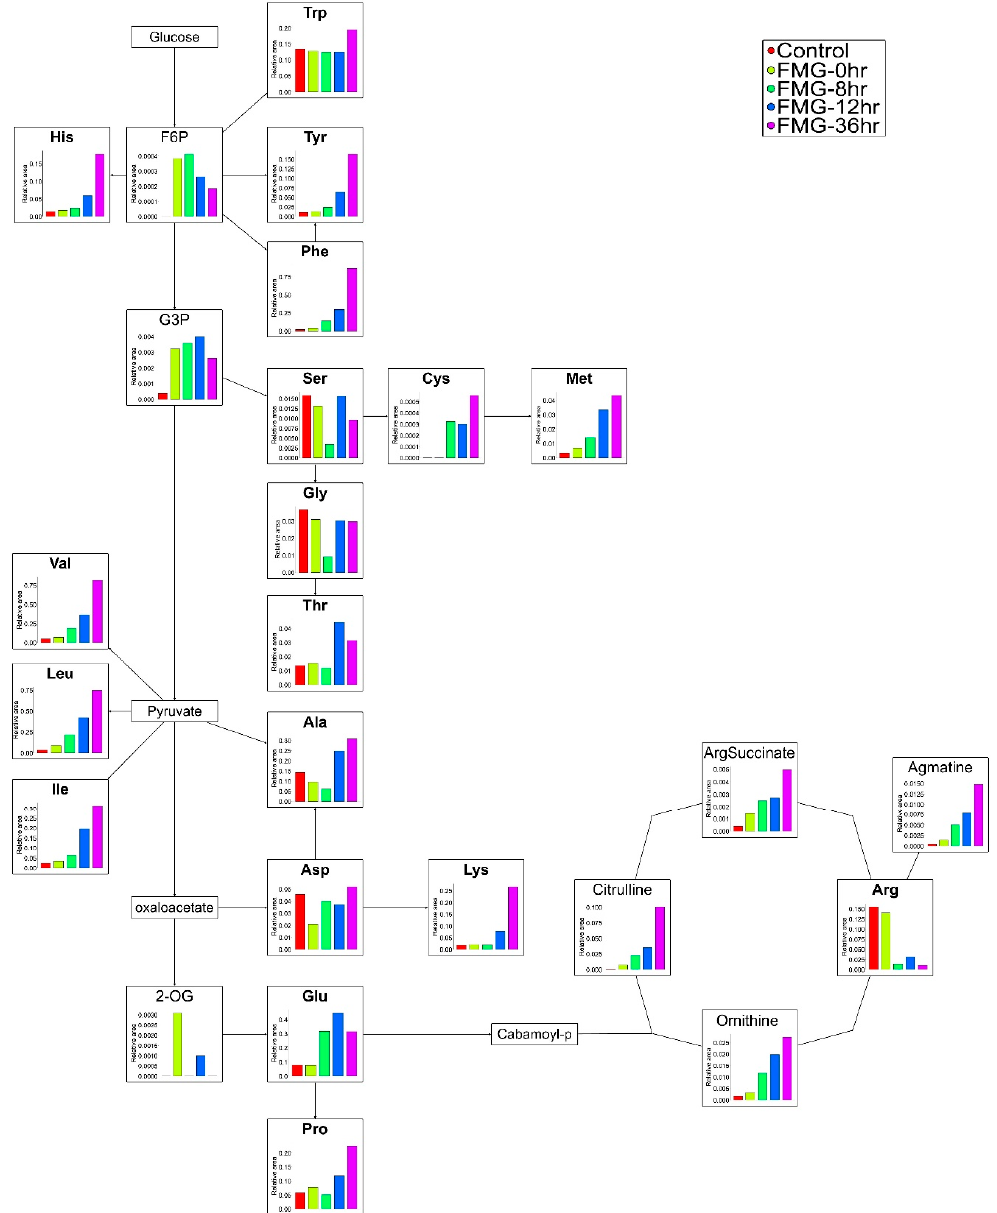
Figure 2. Scheme of the amino acid and the urea and polyamine pathways. The metabolic pathway was adopted from Kyoto Encyclopedia of Genes and Genomes (KEGG database. Changes in the levels of MG metabolites produced by Bacillus amyloliquefaciens 245 during fermentation were detected by capillary electrophoresis time-of-flight mass spectrometry (CE-TOF-MS). Each bar represents the relative metabolite abundance. Red, yellow, green, blue, and purple squares indicate MG (a grain mixture before steaming), FMG-0hr (a mixture of grain steamed for 30 min at 100 °C), FMG-8hr (a mixture of grain fermented for 8 h), FMG-12hr (a mixture of grain fermented for 12 h), and FMG-36hr (a mixture of grain fermented for 36 h), respectively.